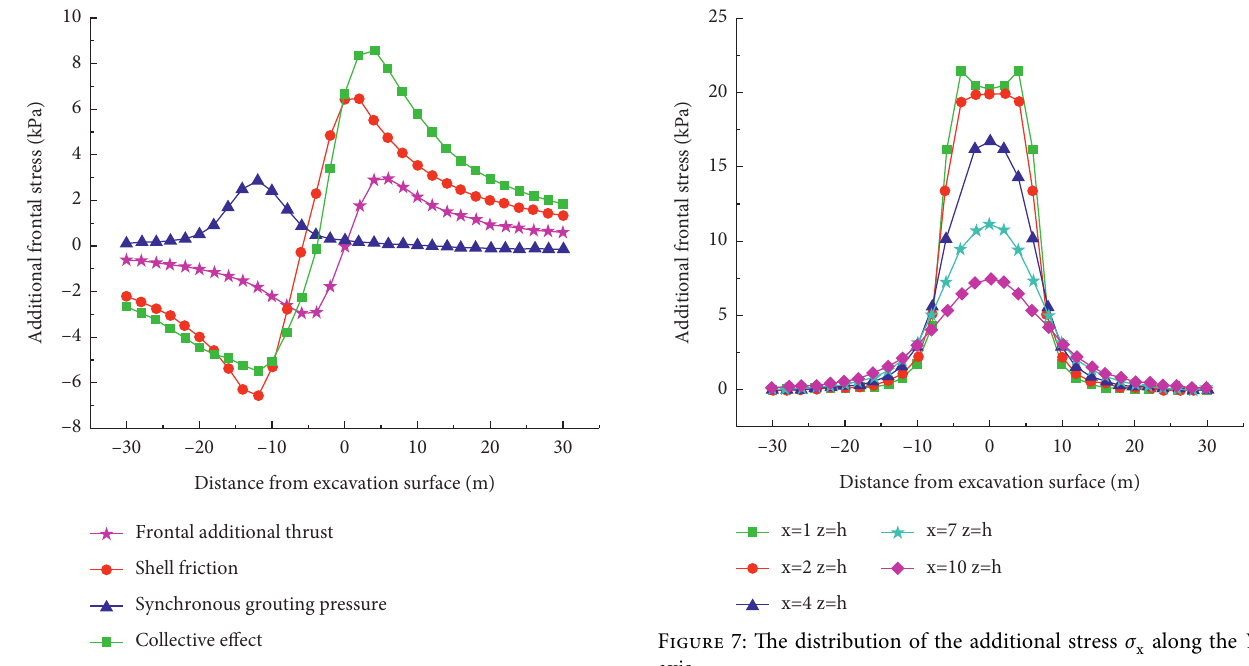
Figure 5: The effect of additional frontal thrust, shell frictional resistance, and synchronous grouting force on σ x .